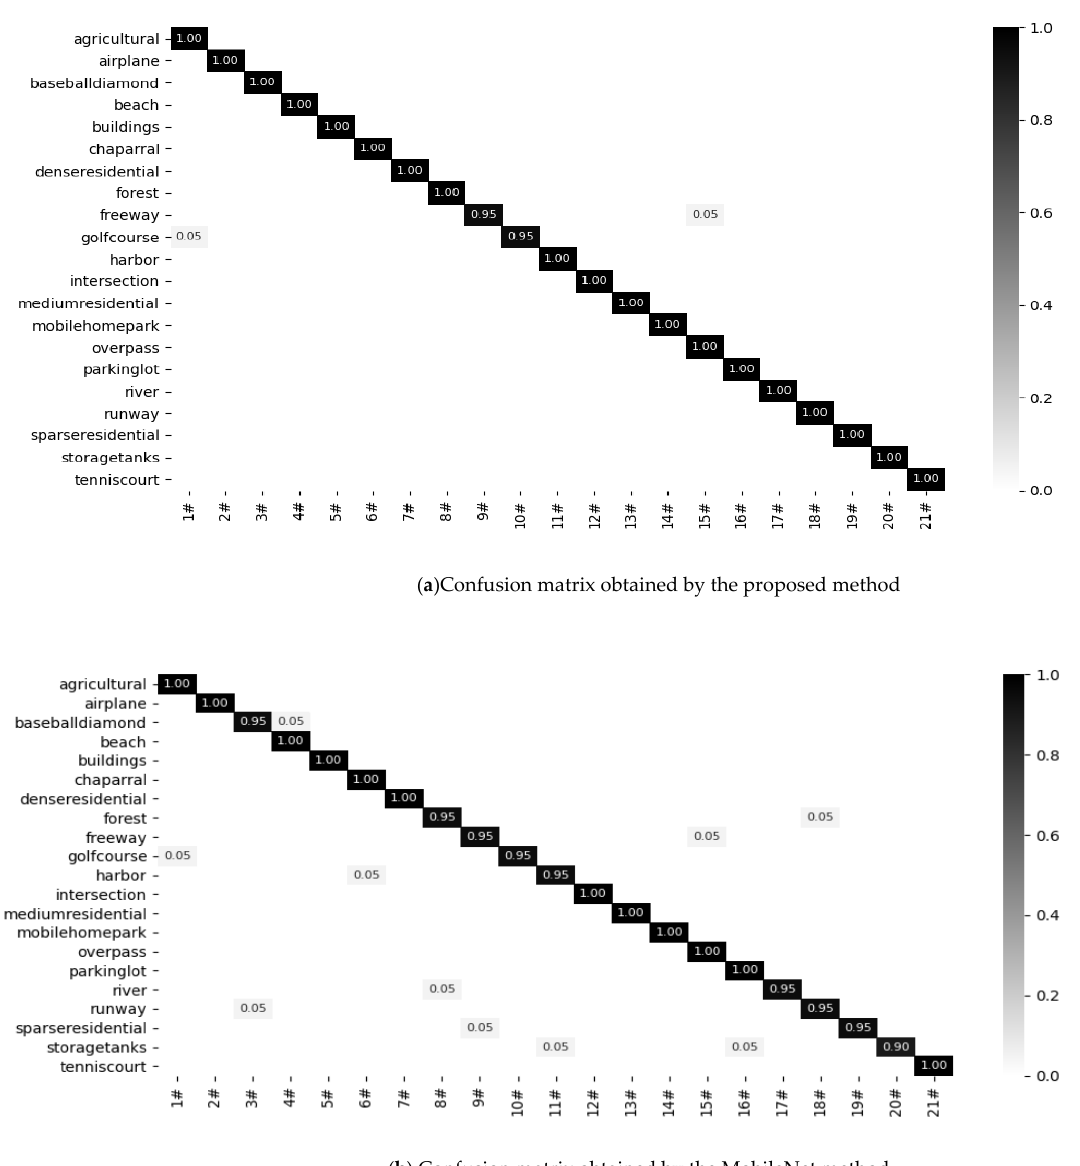
Figure 7. Comparison of the confusion matrix of the proposed method and MobileNet on the UCM21